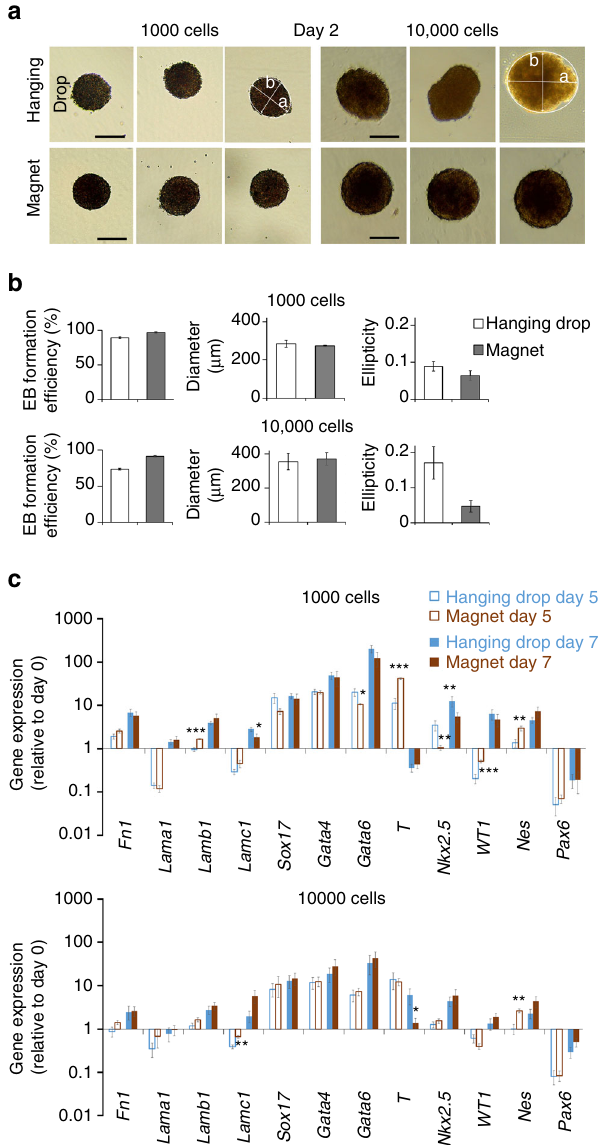
Fig. 4 Comparison between magnetic EB formation and hanging drop method. a Typical images of EBs observed at day 2 after seeding (of 1000 or 10,000 ESCs), either in hanging drop or over a magnetic attractor. The short axis b and the long-axis a of the equivalent ellipse were determined by image analysis (Image J). Scale bar : 200 µ m. b Quanti fi cation over 50 EBs: Ef fi ciency is calculated as the number of EBs actually formed over the number of hanging drops deposited or of magnetic attractors present below the dish; the diameter (expressed in µ m) is the effective diameter computed from the EBs areas; and the ellipticity is de fi ned as 1-b/a. c Expression of a panel of genes characteristic of the different embryonic cell layers in EB obtained with hanging drop or magnetic aggregation with either 1000 or 10,000 cells. All gene expressions were normalized using the reference gene RPLP0 mRNA, and calculated relatively to the expression of the same gene obtained at day 0, prior to EB formation. The values varied very little from one condition to another. Even statistically signi fi cant differences (over- or under-expression) were small: with 1000 cells on day 5, Lamb1 expression increased by a factor of 1.7 and T expression by 3.7, while Nkx2.5 fell by a factor of 3.2, Wt1 rose by 2.5 and Nes rose by 2.1. On day 7, Lamc1 expression fell 1.5-fold and Nkx2.5 fell 2.3-fold. With 10,000 cells, Lamc1 increased 1.7-fold and Nes 2.6-fold on day 5, while T fell 4.2-fold on day 7. All error bars represent the